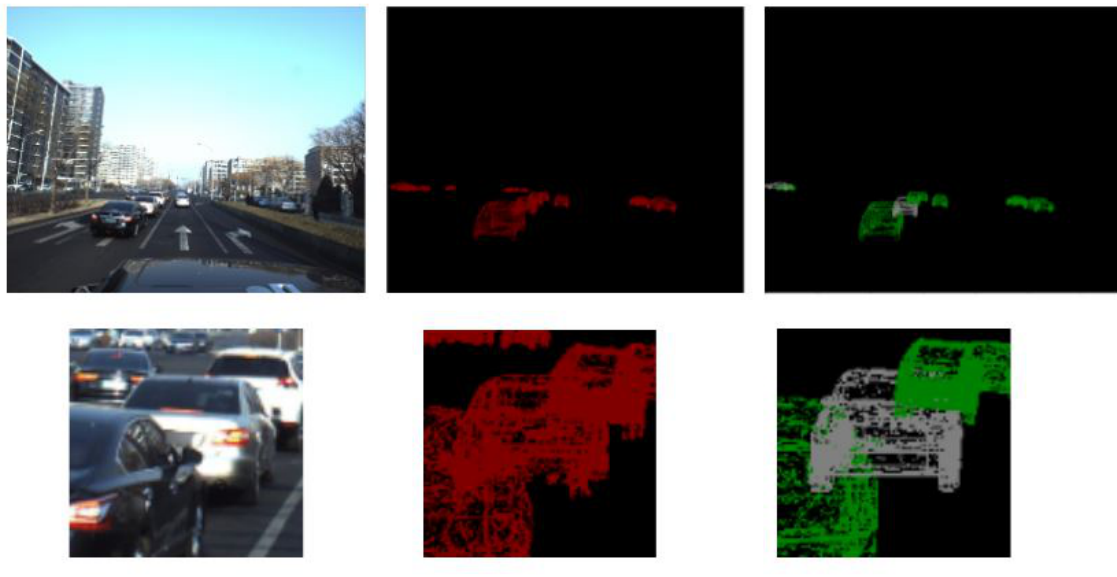
Figure 11. Visualization of model predictions (green) in comparison with the ground truth (red) where white predictions present the misclassified